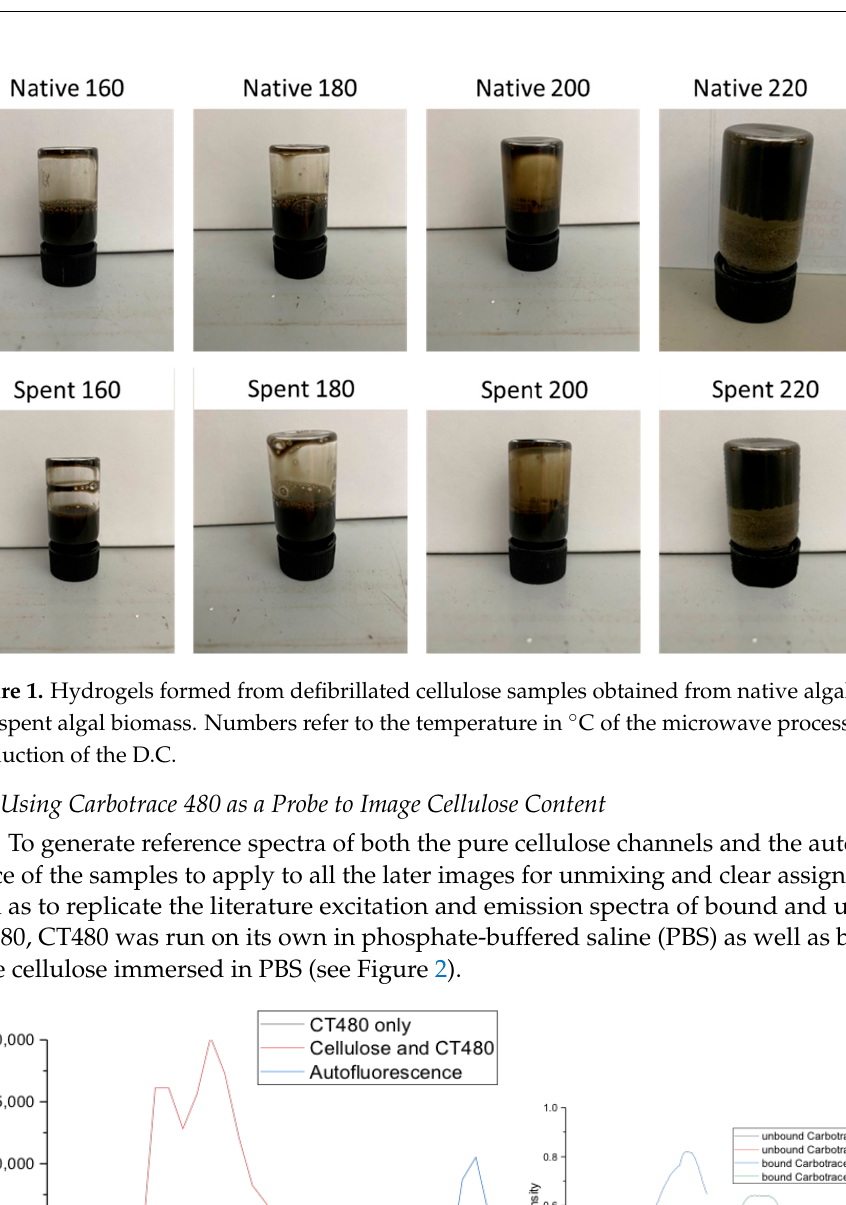
Figure 1. Hydrogels formed from defibrillated cellulose samples obtained from native algal biomass and spent algal biomass. Numbers refer to the temperature in  C of the microwave process used for production of the D.C.